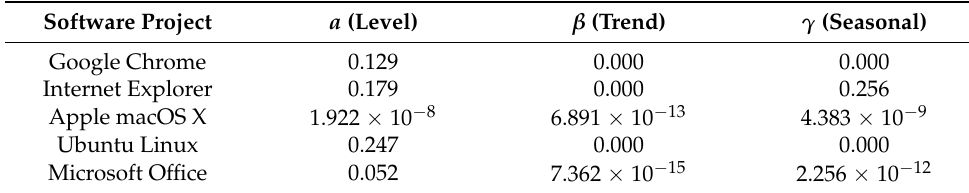
Table 4. Optimal parameters for exponential smoothing models.